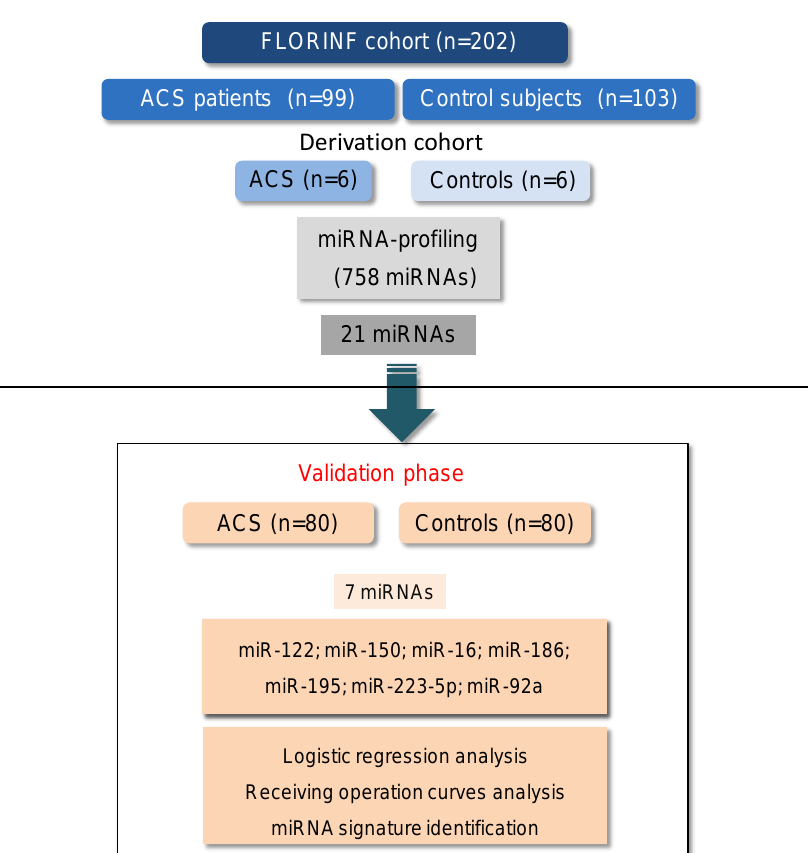
Figure 1. Study design and workflow. Cases (men and women) were patients who experienced an acute coronary syndrome (ACS patients) and were included one week after the acute ischemic event; controls (men and women) were asymptomatic subjects at high to very high cardiovascular risk without any coronary disease. Twenty-one miRNA candidates identified in the miRNA-profiling from the derivation cohort were analyzed in the validation phase. Nineteen samples from the 99 ACS patient cohort and 23 samples from the 103 control subject cohort were excluded because of poor RNA quality. In the validation cohort (ACS, n = 80; controls, n = 80), seven miRNAs were significantly differentially expressed in cases and controls and tested for logistic regression and ROC analyses.